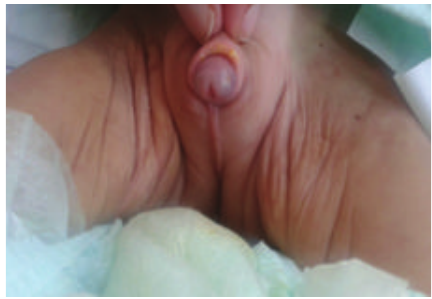
Figure 2: Case 1: curvature of the penis.